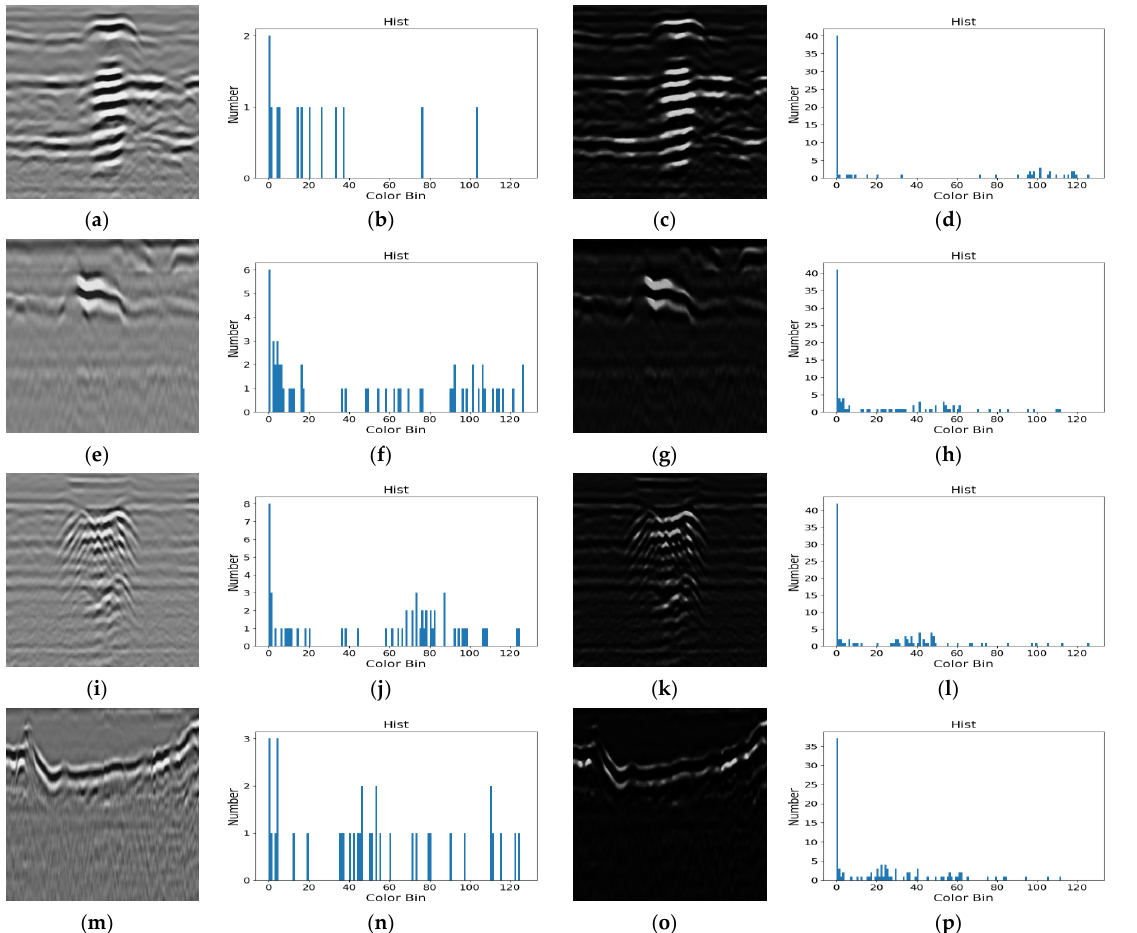
Figure 7. Gamma transform effect and gray histogram statistical comparison: Gamma transform effect and gray histogram statistical comparison: Filtered GPR images 1 − 4 ( a , e , i , m ); Gray histogram of image 1 − 4 ( b , f , j , n ); Gamma transformed GPR images 1 − 4 ( c , g , k , o ); Gray histogram of Gamma transformed GPR image 1 − 4 ( d , h , l , p ).